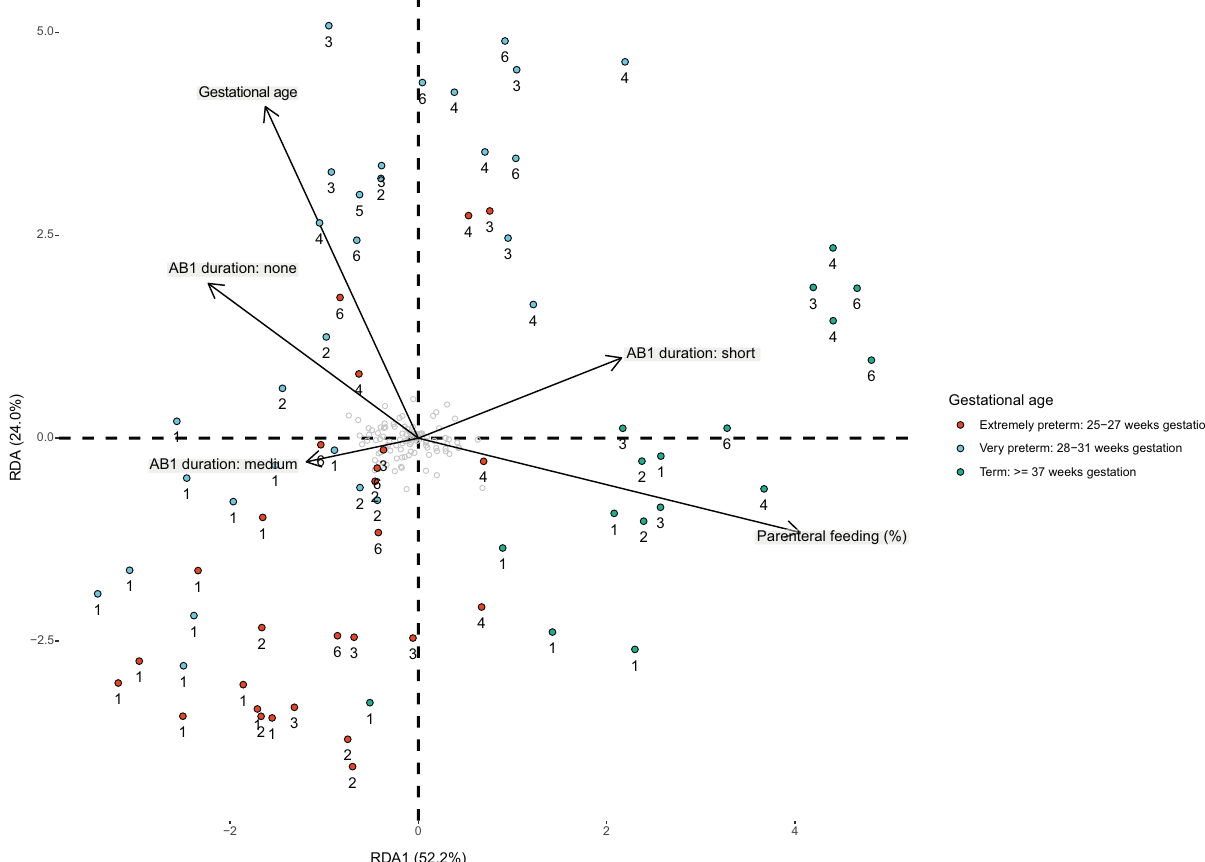
Figure 4. Redundancy analysis on the fecal proteome of preterm and term infants during the first six postnatal weeks. Clinical variables shown by arrows significantly explain variation in the proteome as selected by forward and reverse automatic stepwise model selection. Colored points indicate infant samples of one timepoint, numbers indicate the corresponding postnatal week and grey points indicate centroids of identified proteins. AB1: first antibiotic treatment including no treatment and treatment of short (< 3 days) or medium (3–5 days)